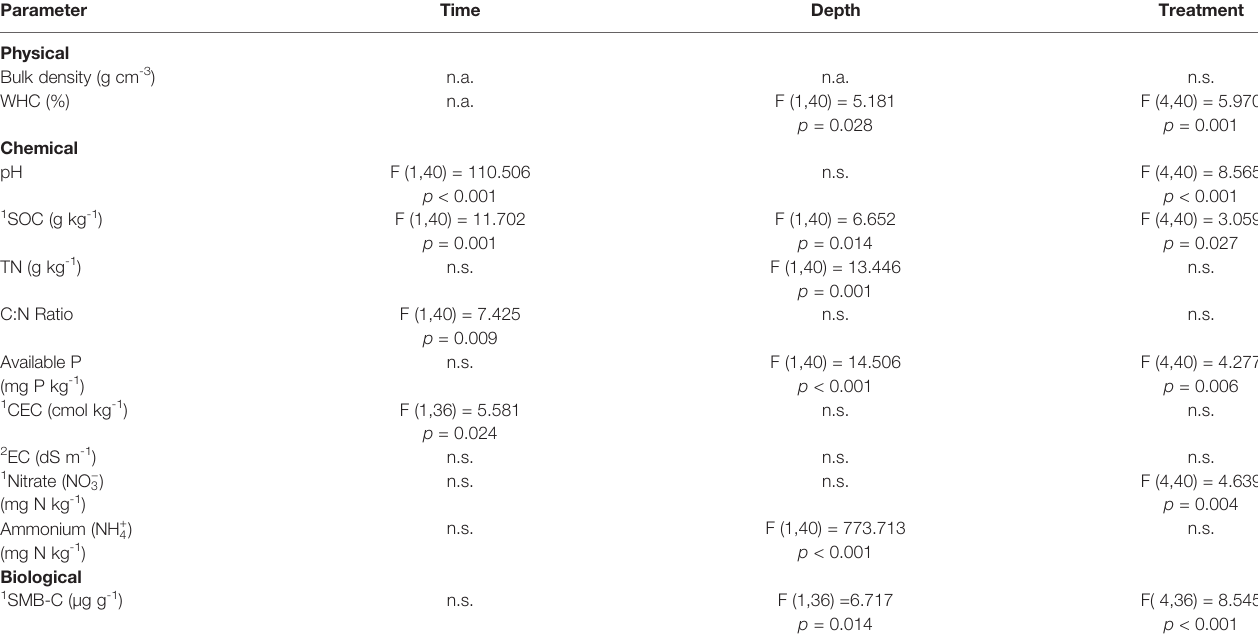
TABLE 5 | Summary of statistical signi fi cance of soil physical, chemical, and biological parameters using factorial analysis of variance (ANOVA) for time, treatment, and depth factors. Parameter